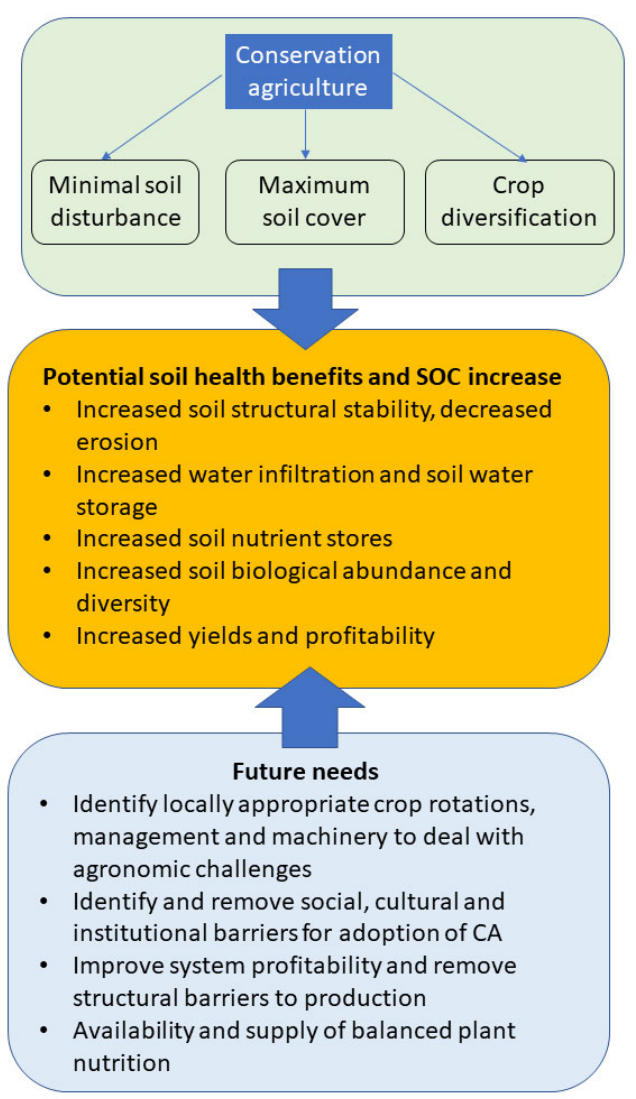
Figure 1. Principles of conservation agriculture, benefits of increasing SOC, and future needs. Modified from [7].